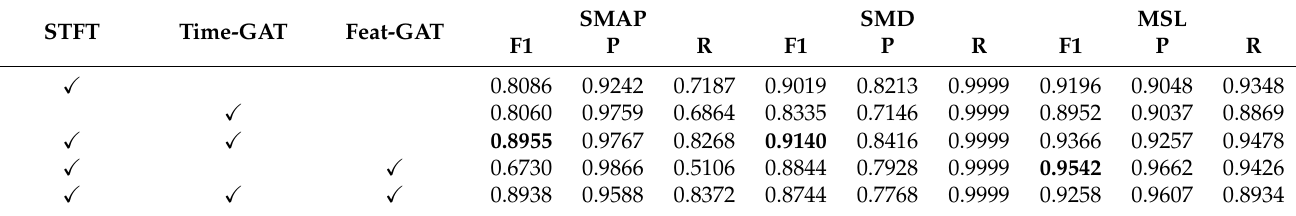
Table 4. The effects of dual-channel feature extraction module on three datasets. The best results are highlighted in bold. (cid:88) indicates that the module is used for